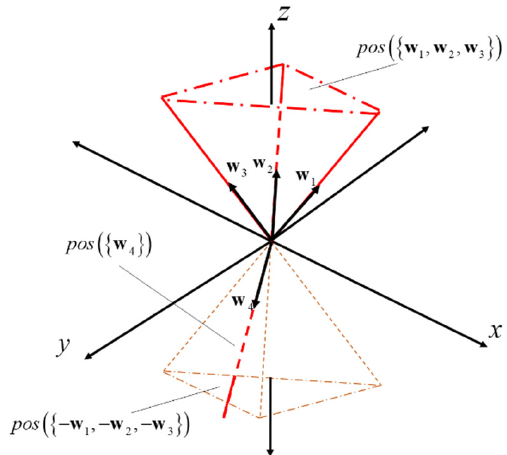
Figure 4. Specific case of a certain 1-redundant actuator-planar CDPM when general coordinates of moving platform are presented in the wrench-closure workspace.